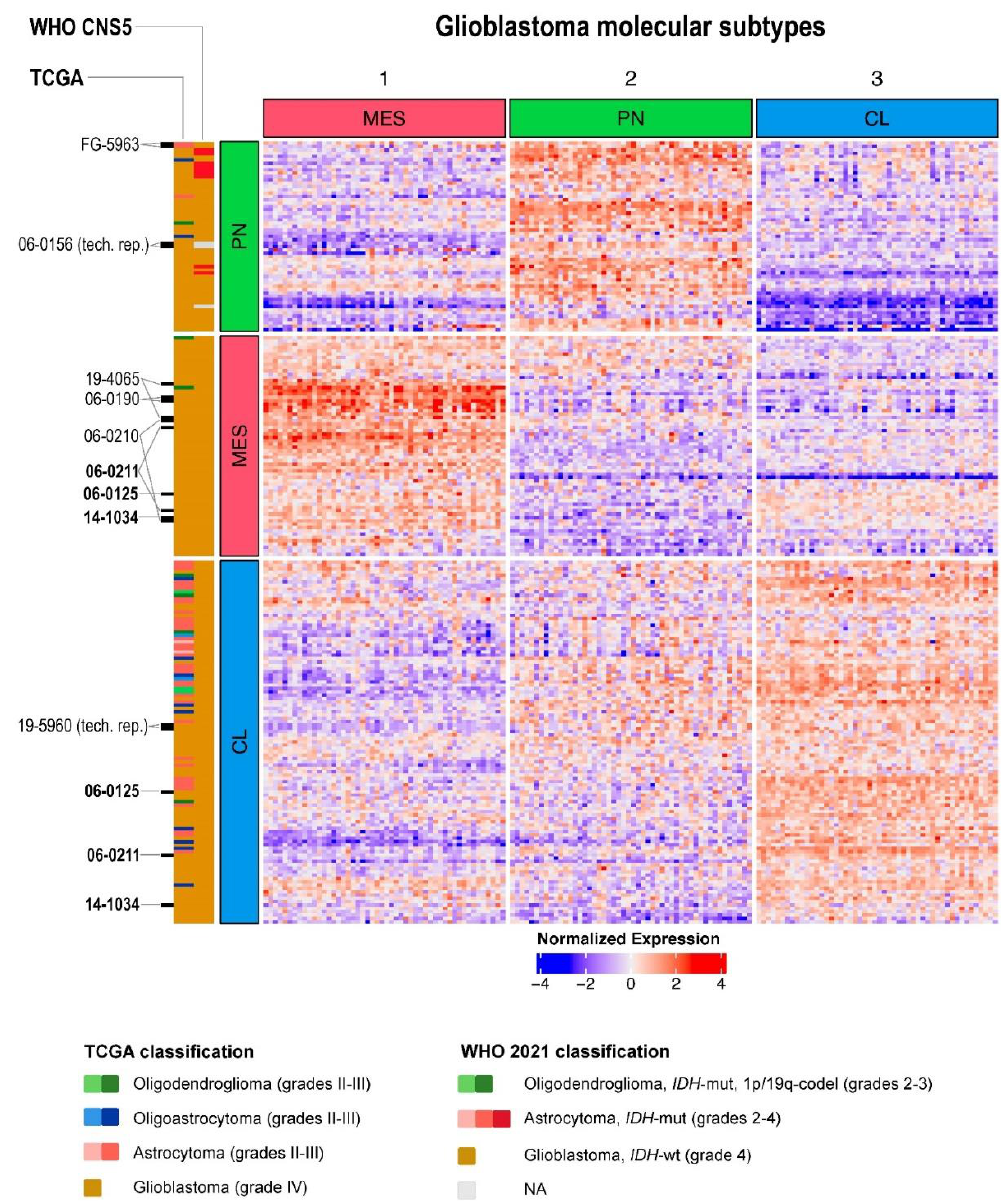
Figure 6. Heatmap of 50-gene signatures for three glioblastoma subtypes [28]. Transcriptomic profiles for glioblastoma samples were taken from combined TCGA-LGG and TCGA-GBM databases. Color markers indicate tumor labels according to TCGA clinical annotation, or according to the WHO CNS5 criteria. Clinical cases with two or more transcriptome profiles are highlighted (samples that fall into different clusters are additionally highlighted in bold). MES—Mesenchymal subtype; PN—Proneural subtype; CL—Classical subtype; NA—diagnosis is not available due to insufficient data about molecular features of a tumor.